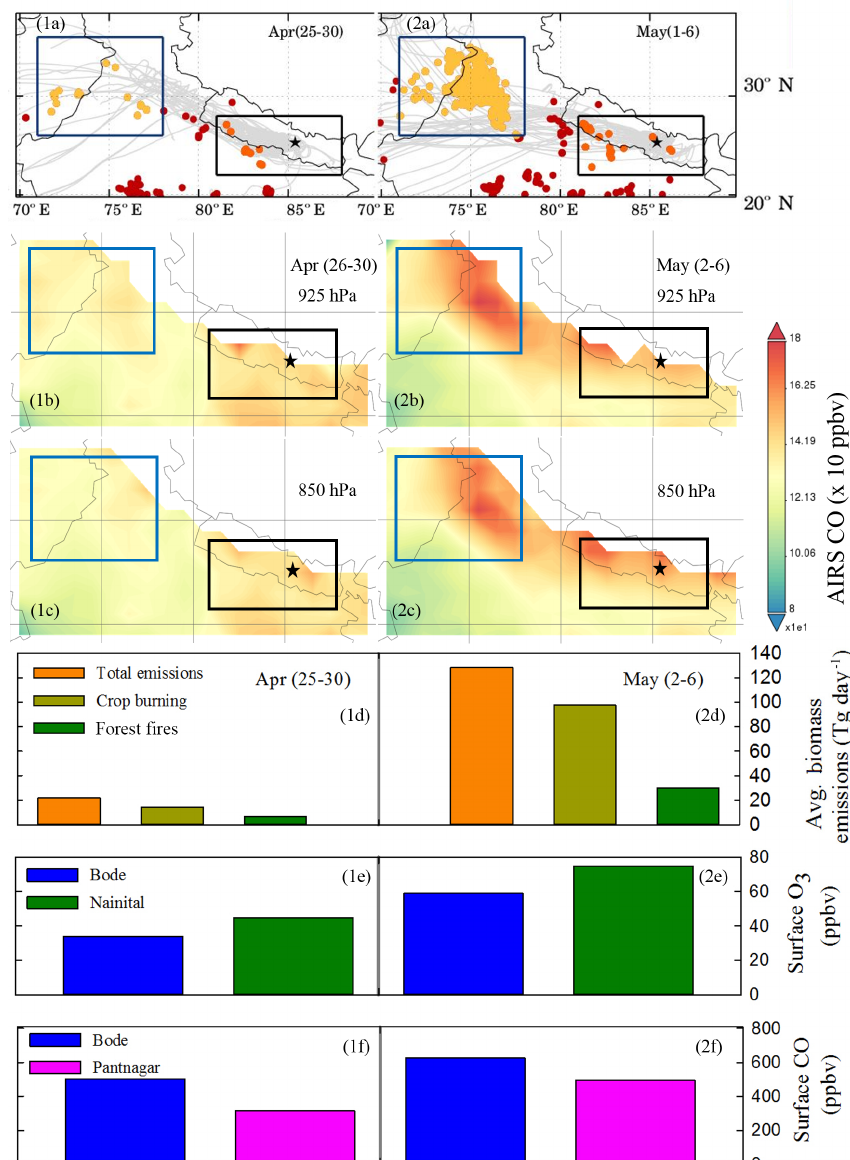
Figure 15. Top (1a–2b) : spatial distribution of MODIS fire counts over the northern Indian subcontinent during the two periods (left to right). The black boxes represent two fire hot spots (refer to Fig. S1) over the region, with fire counts shown as different colors during different periods. Center (1b–2c) : spatial distribution of AIRS CO mixing ratio at 925hPa (1b–2b) and 850hPa (1c–2c) during the two periods (left to right). Center (1d–2d) : average biomass burning emissions over the Bode region (27–8 ◦ E, 85–86 ◦ E) using the GFED v4.0 inventory during the two periods (left to right). Bottom (1e–2f) : changes in average surface mixing ratios of O 3 (1e–2e) and CO (1f–2f) at different sites during the two periods (left to